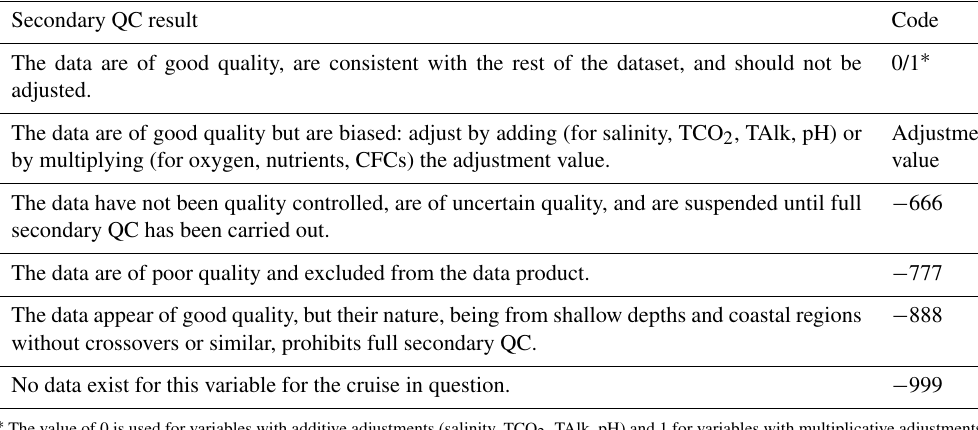
Table 6. Summary of secondary QC results for the 43 new cruises, in number of cruises per result and per variable. Sal.